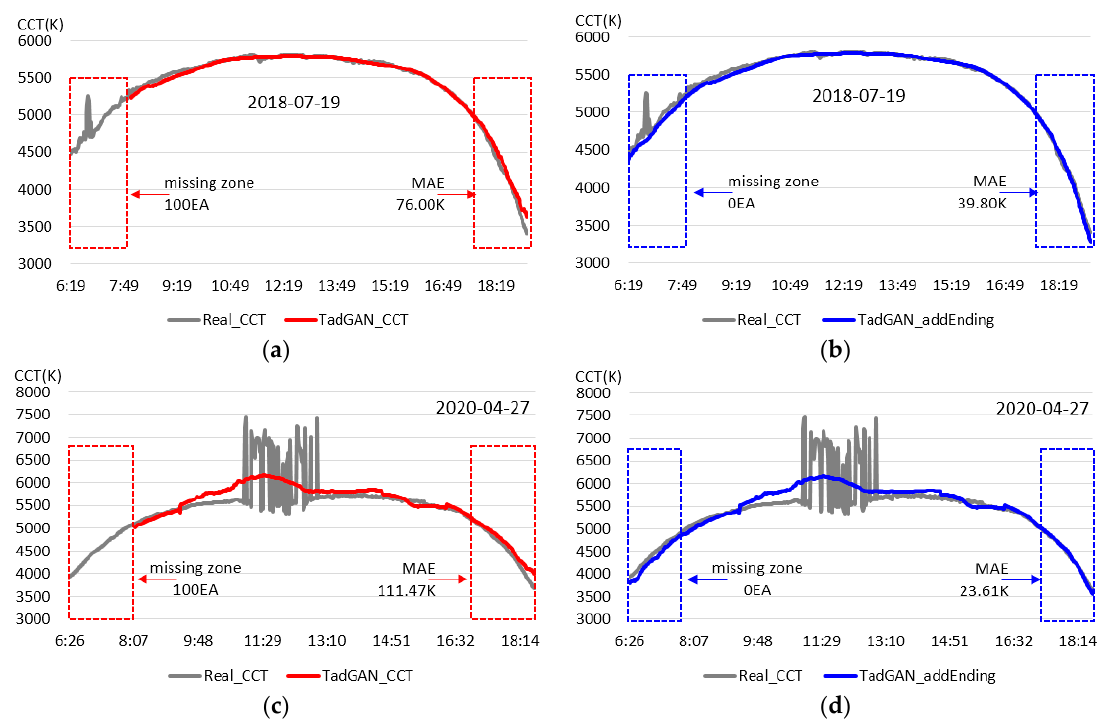
Figure 7. Real-time daily color temperature cycle generation result (irregular color temperature inclusion within 10%). ( a ) Irregular color temperature inclusion ratio of 2% (the conventional method); ( b ) Irregular color temperature inclusion ratio of 2% (the proposed method); ( c ) Irregular color temperature inclusion ratio of 10% (the conventional method); ( d ) Irregular color temperature inclusion ratio of 10% (the proposed method).